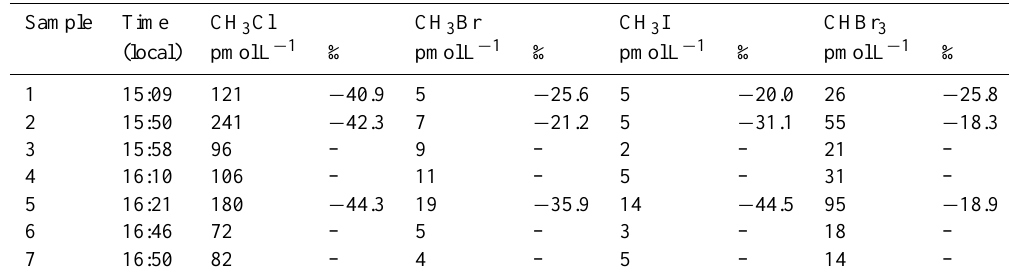
Table 2. Water concentration (pmolL − 1 ) and stable carbon isotope ratios of halocarbons (‰) obtained from a 2h transect cruise on 24 April 2012 (see Fig. 1 for sampling